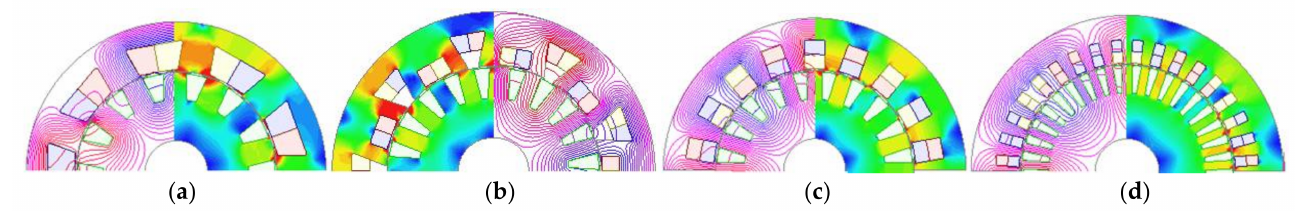
Figure 18. Flux line and density distributions. ( a ) 9S/6P/14R-DL; ( b ) 18S/6P/20R-DL (ANW); ( c ) 18S/6P/20R-DL; ( d ) 36S/6P/38R-DL.